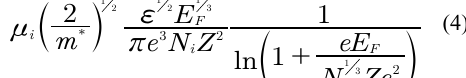
) determination. g